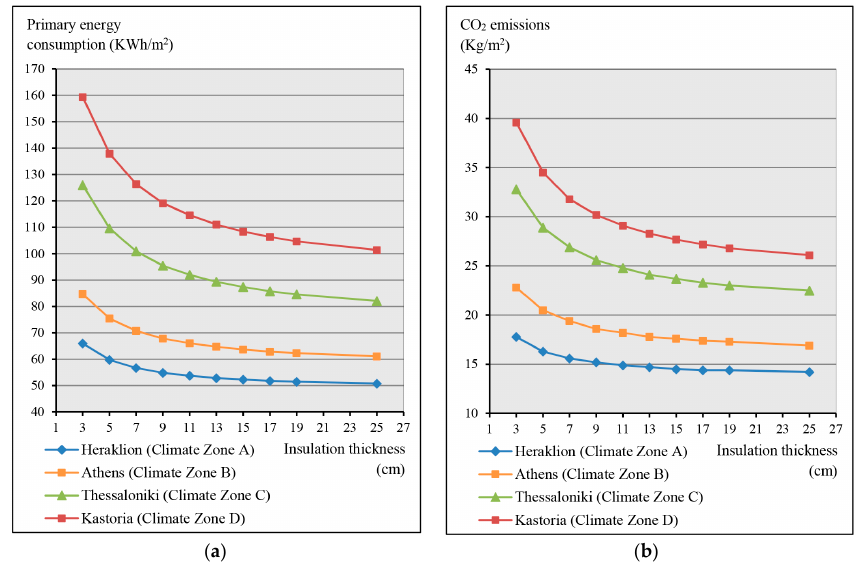
Figure 2. Results of ( a ) primary energy consumption in Kwh/m 2 and ( b ) CO 2 emissions in Kg/m 2 of the reference building for the 10 insulation scenarios on each climate